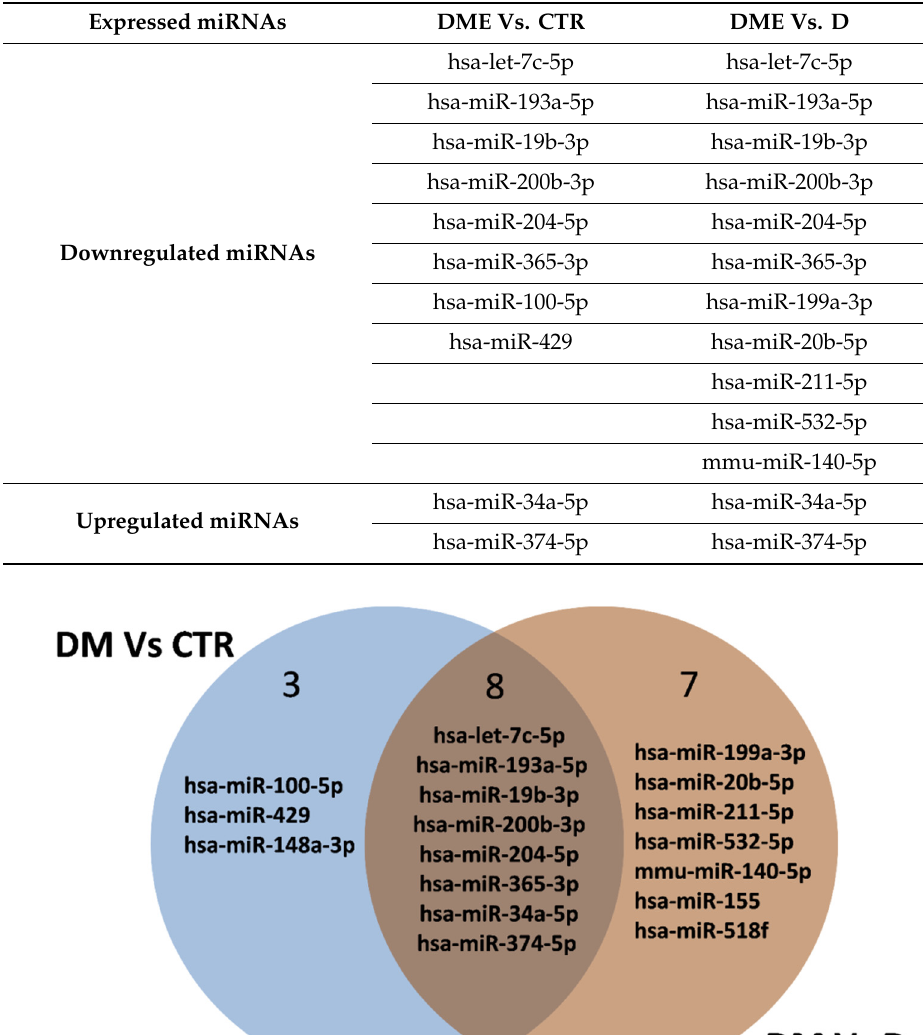
Table 2. List of differentially expressed miRNAs following profiling analyses in AH of DME vs CTR group ( n = 11; n = 8 downregulated miRNAs and n = 3 upregulated miRNAs) and in AH of DME vs. D group ( n = 15 miRNAs; n = 11 downregulated miRNAs and n = 4 upregulated miRNAs). Expressed miRNAs